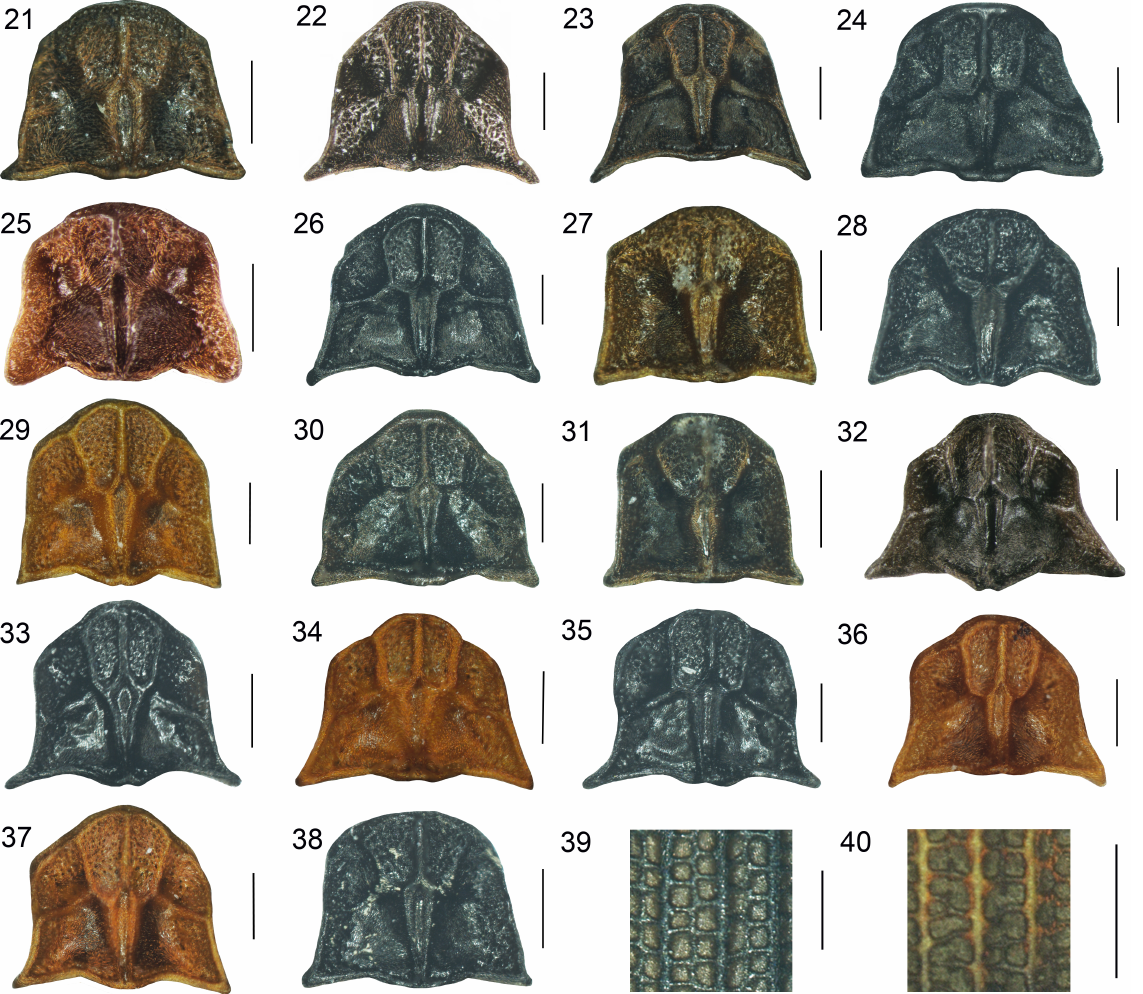
Figs 21–38. Male pronotum. 21 . Cautires alexae sp. nov. 22 . C. andujari sp. nov. 23 . C. arribasae sp.